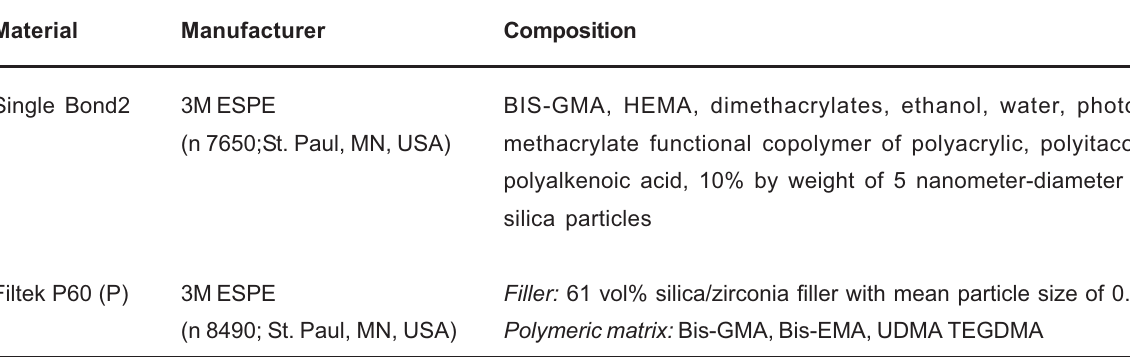
TABLE 1- Composition of materials used in restorative procedures